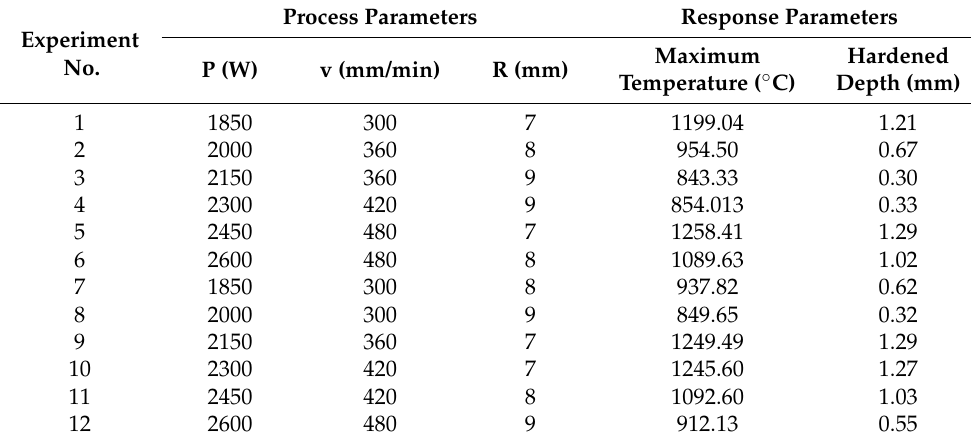
Table 4. Uniform experimental design and response parameters.